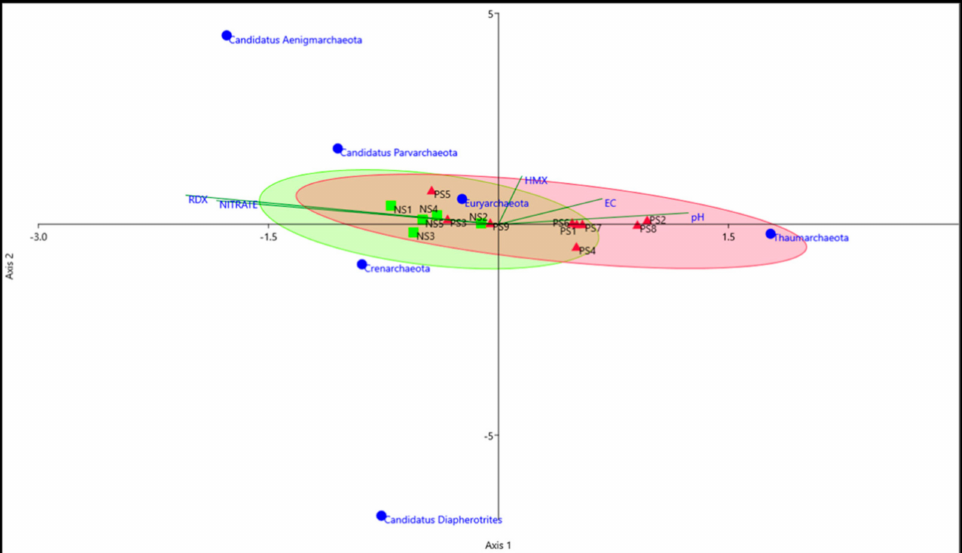
Figure 6. Canonical correspondence analysis (CCA) plot between environmental variables and phylum level diversity. Triplot represent environmental variables. Filled squares and triangles represent samples from SITE1 and 2, respectively. CCA plot was constructed based on bootstrap N:999, p =